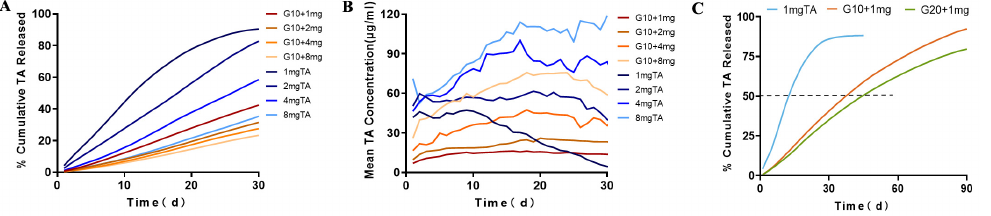
Figure 3. In vitro release profiles for the release of TA from GelMA + TA and TA suspension. ( A ) Cumulative TA release against varying TA-loading concentration from 10% GelMA and suspension over a period of 30 d. ( B ) Mean concentration of TA release against varying TA-loading concentration from 10% GelMA and suspension over a period of 30 d. ( C ) Cumulative TA release against 1 mg TA-loading concentration from 10%, 20% GelMA and suspension during incubation at 37 °C for 90 d with constant shaking at 50 rpm ( n = 3). Table 1. Measured the in vitro triamcinolone acetonide release from GelMA. Group